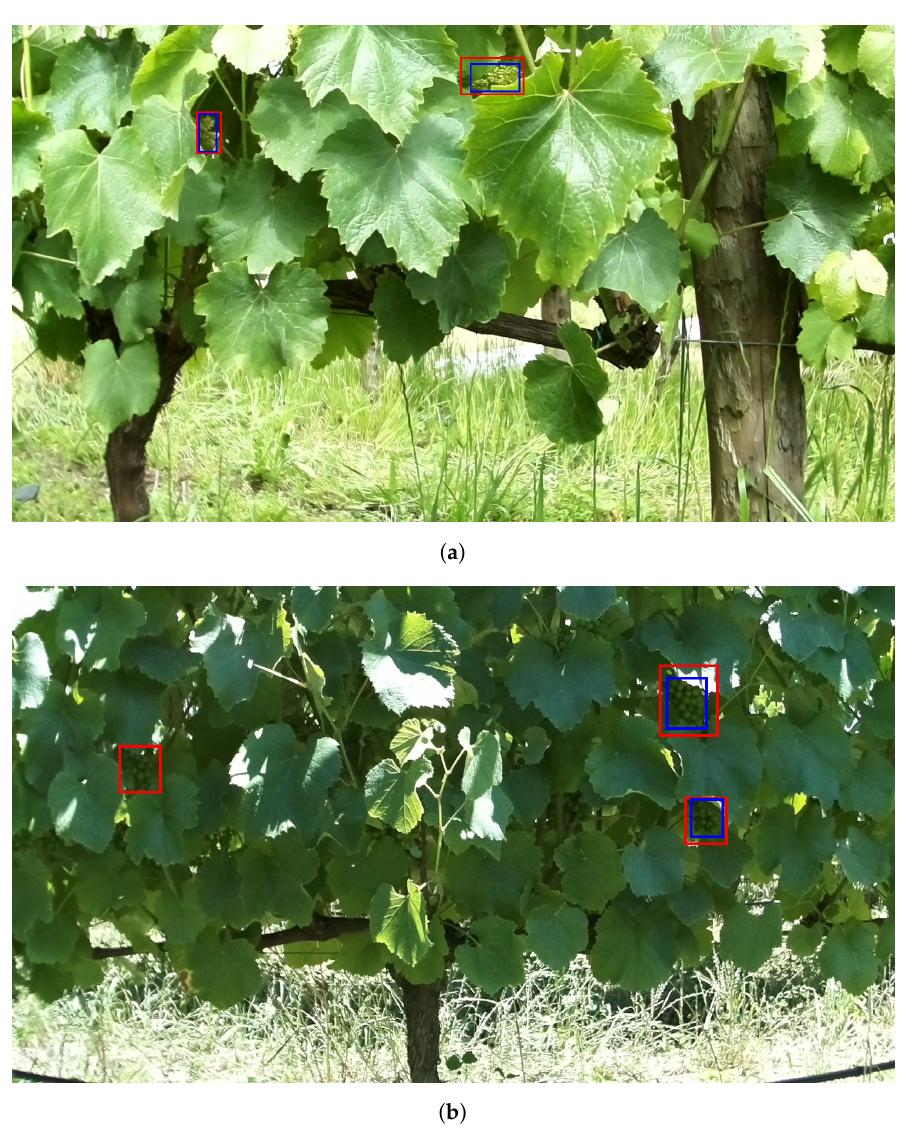
Figure 10. Detection of grape bunches ( a ) in early, and ( b ) intermediate growth stages considering occlusions caused by the dense foliage present in the vineyard. Blue bounding boxes represent the ground truth and the red ones the